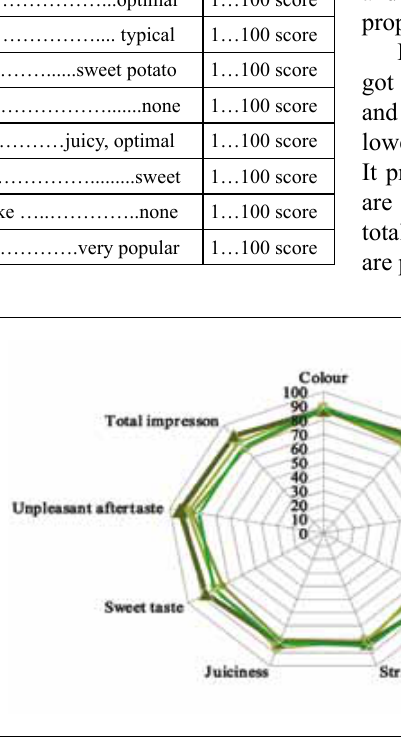
Figure 1. Sensory evaluation of asparagus hybrids (Debrecen-Pallag, 2013)